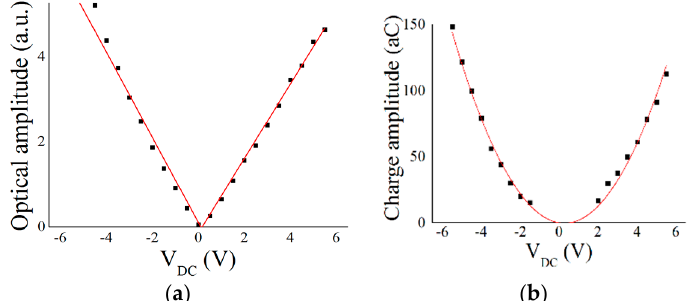
Figure 3. Fitted measurements of the vibration signals at resonance versus V DC . Optical measurements ( a ) were made for V AC = 140 mV and capacitive measurements ( b ) for V AC = 600